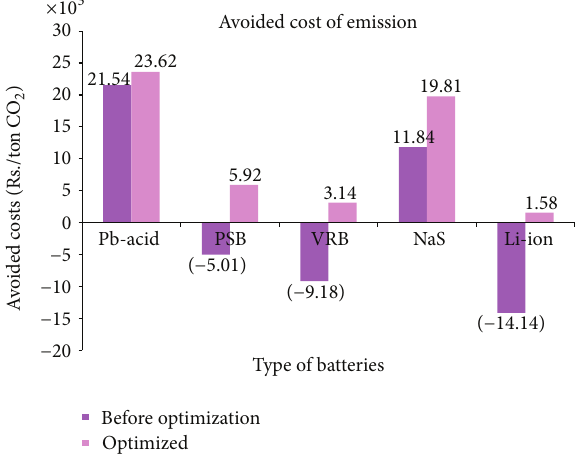
Figure 16: Avoided cost of